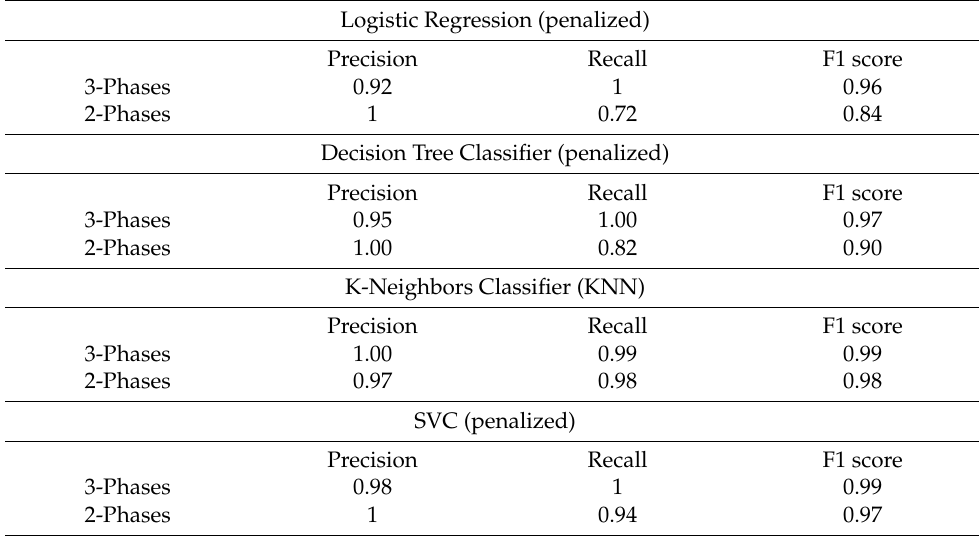
Figure 19. Confusion Matrix for Strategy 2. Table 7. Classification Reports for Strategy Table 7. Classification Reports for Strategy 2.